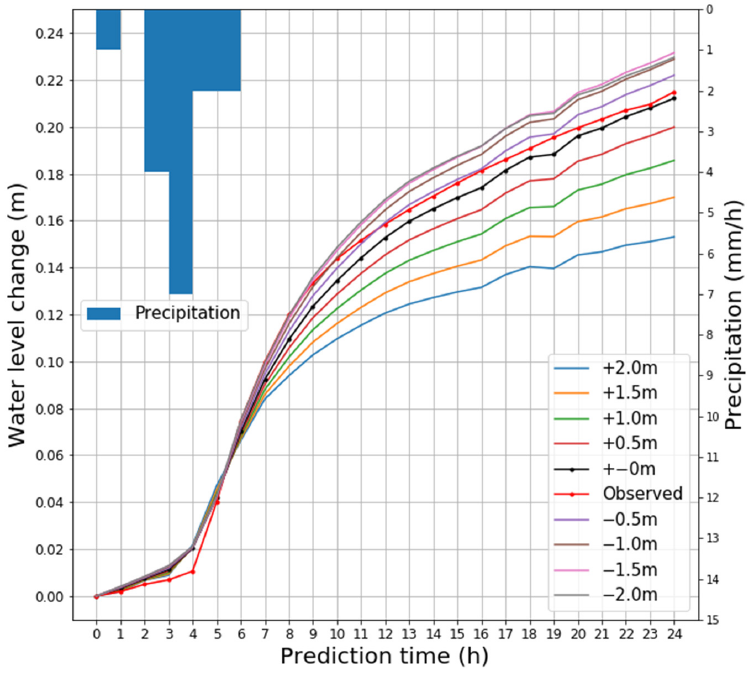
Figure 5. Water-level changes with different initial water levels (from − 2.0 m to 2.0 m), using the LSTM ED1 model.